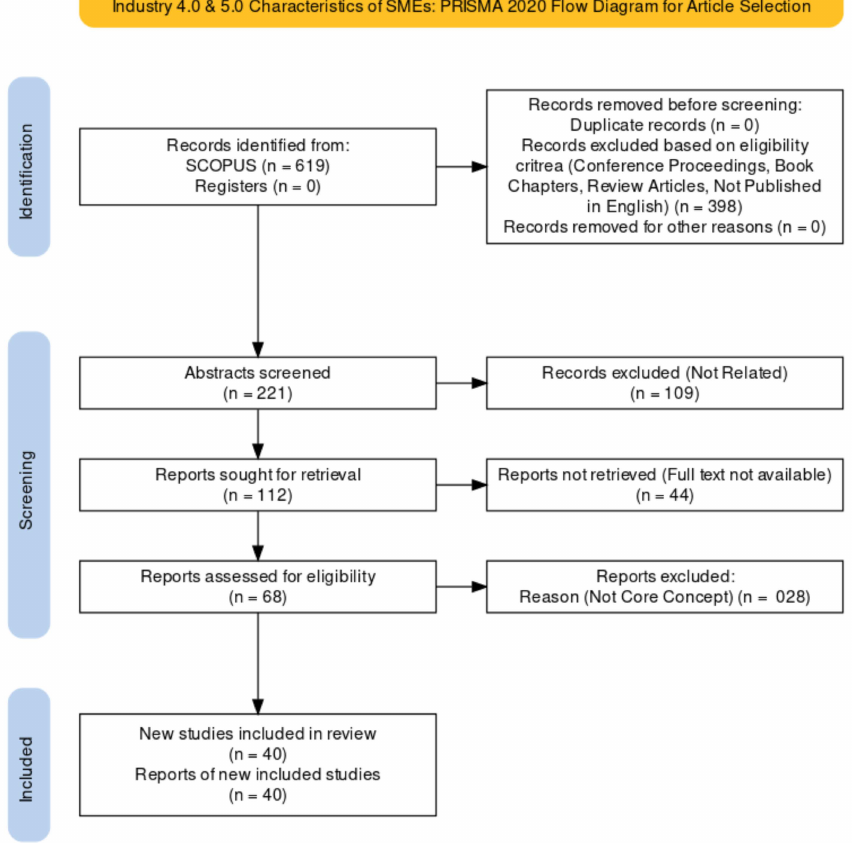
Figure 7. PRISMA 2020 of Article